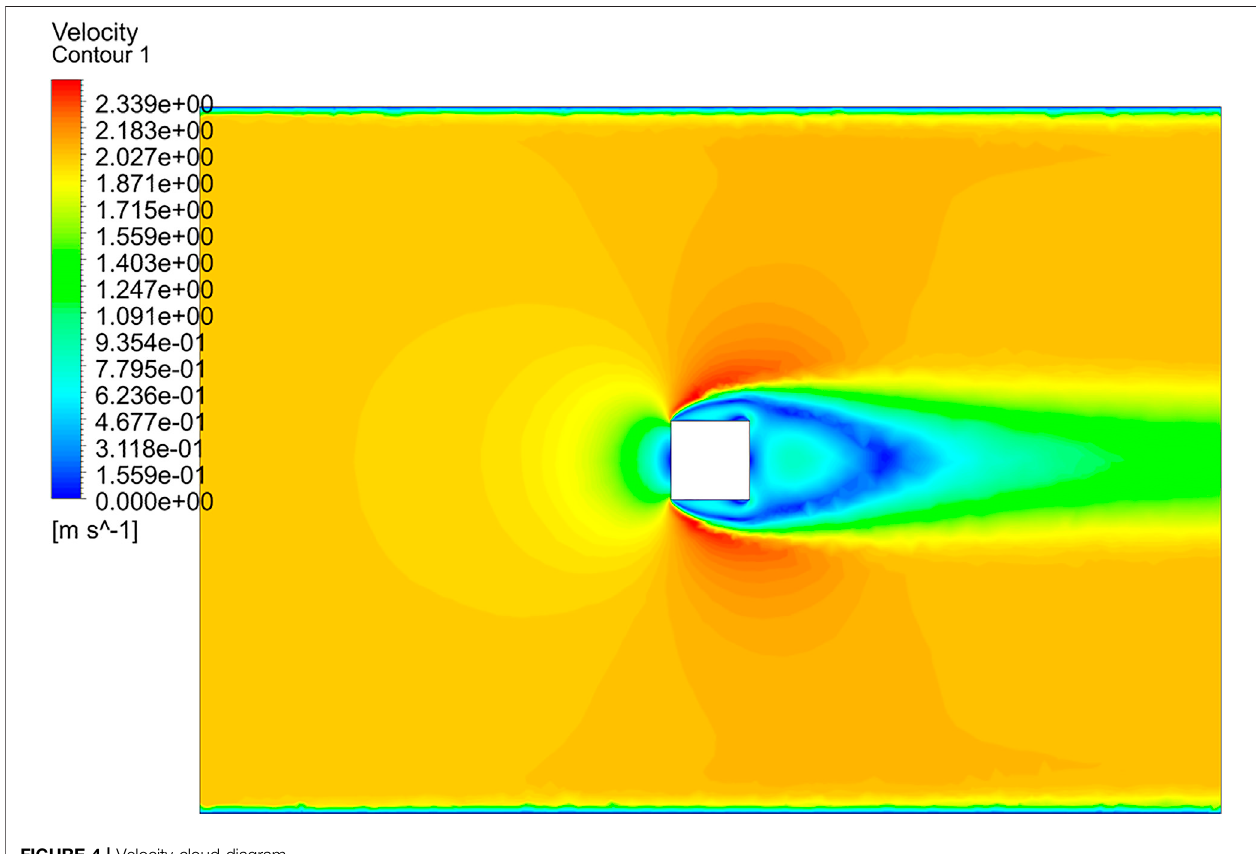
FIGURE 4 | Velocity cloud diagram.